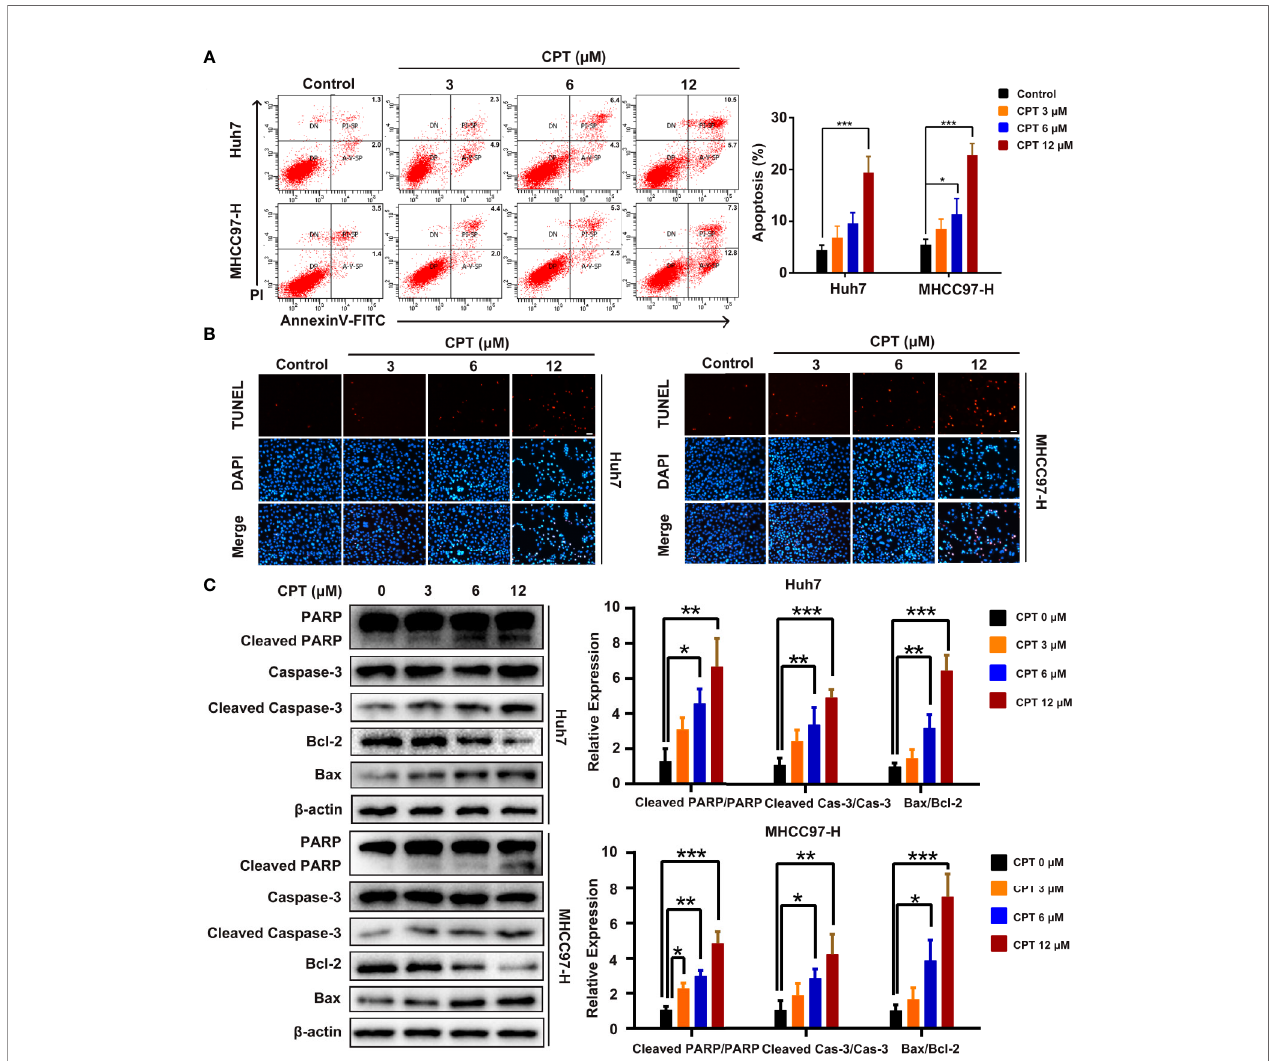
FIGURE 7 | Cryptotanshinone (CPT) induces apoptosis in Huh7 and MHCC97-H cells. (A) Huh7 and MHCC97-H cells were treated with CPT (0, 3, 6, and 12 m M) for 24 h and analyzed using the Annexin V-FITC apoptosis detection kit. (B) TUNEL assay in Huh7 and MHCC97-H cells after treatment with CPT (0, 3, 6, and 12 m M). (C) Expression levels of PARP, cleaved PARP, caspase-3, cleaved caspase-3, Bcl-2, and Bax proteins in Huh7 and MHCC97-H cells following CPT (0, 3, 6, and 12 m M) treatment were detected by western blotting. * P < 0.05, ** P < 0.01, and *** P < 0.001 versus the control